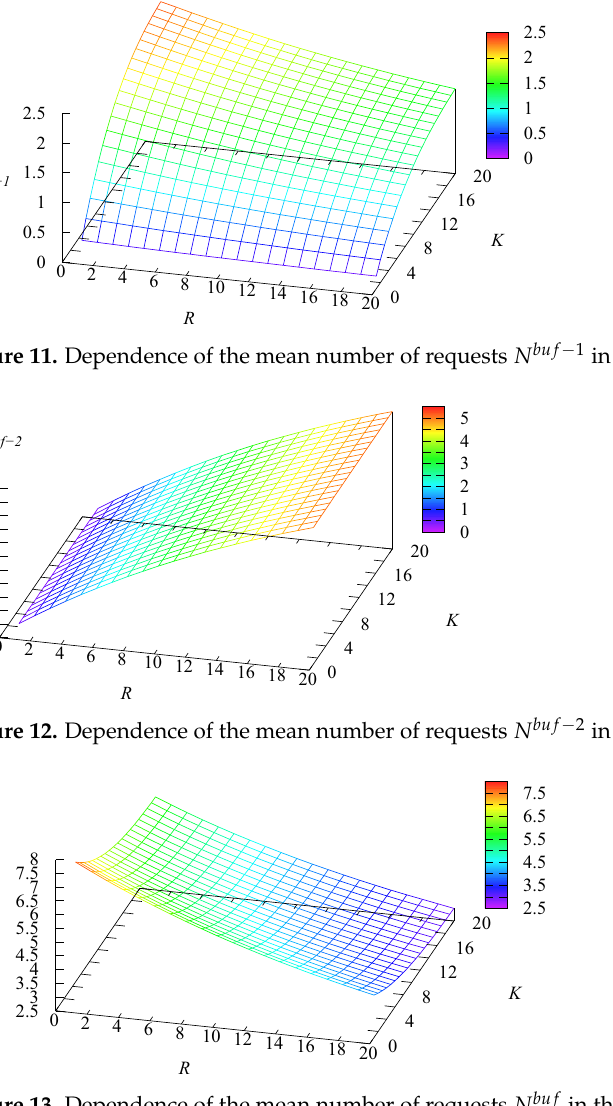
Figure 13. Dependence of the mean number of requests N buf in the main buffer on K and R